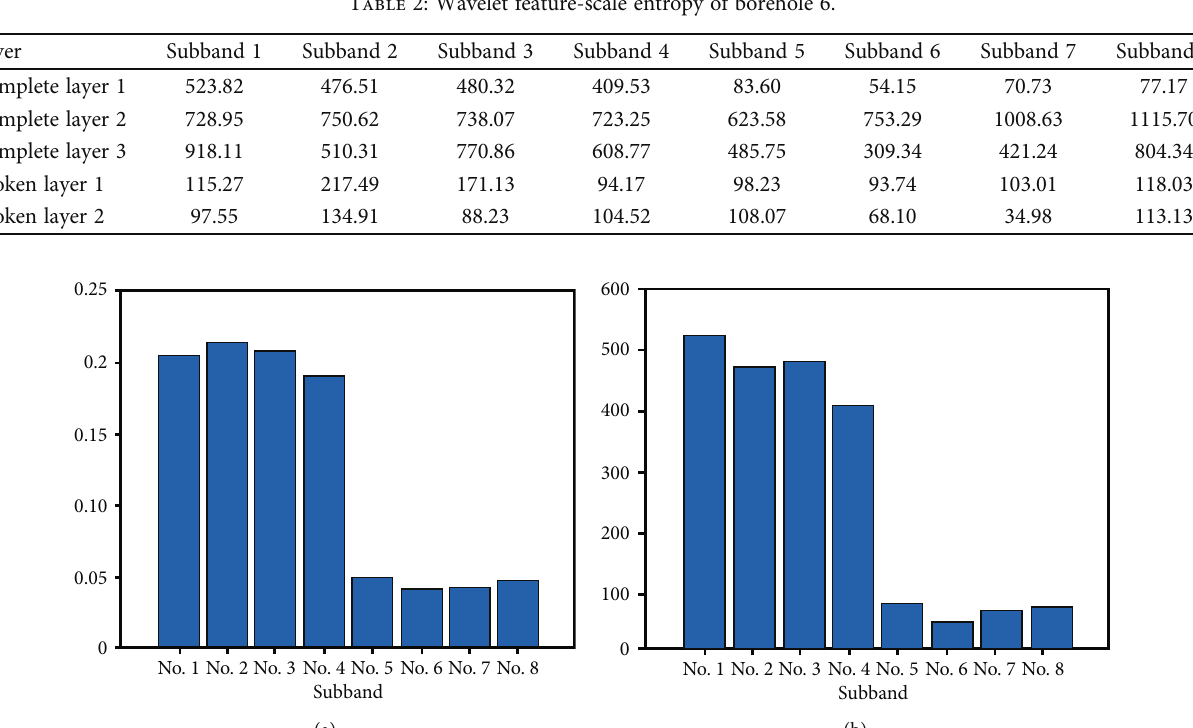
Figure 13: Wavelet decomposition subband energy ratio (a) and wavelet feature-scale entropy (b) of complete layer 1.